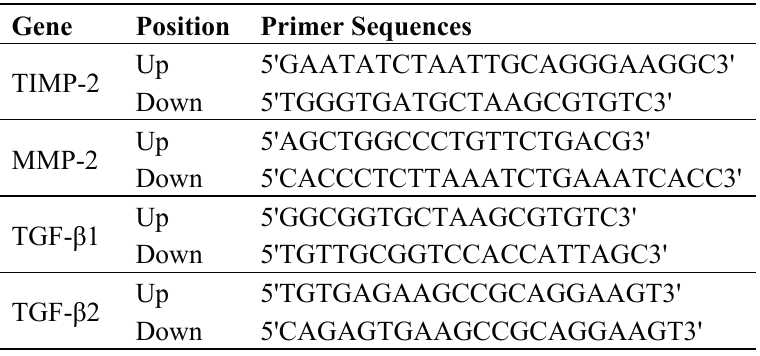
Table 1. Sequence of oligonucleotides used as PCR